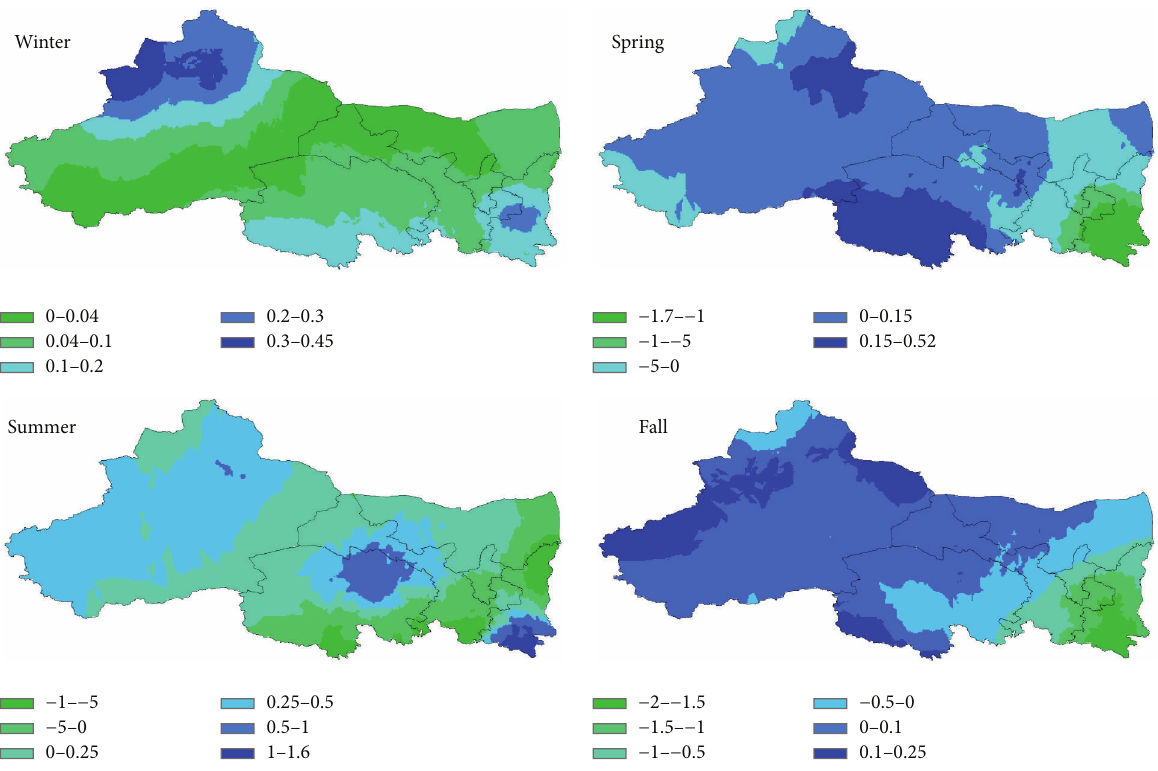
Figure 3: Spatial distribution of 𝛽 -values for seasonal precipitation during 1960–2008. Quantities show changes in annual precipitation in mm per